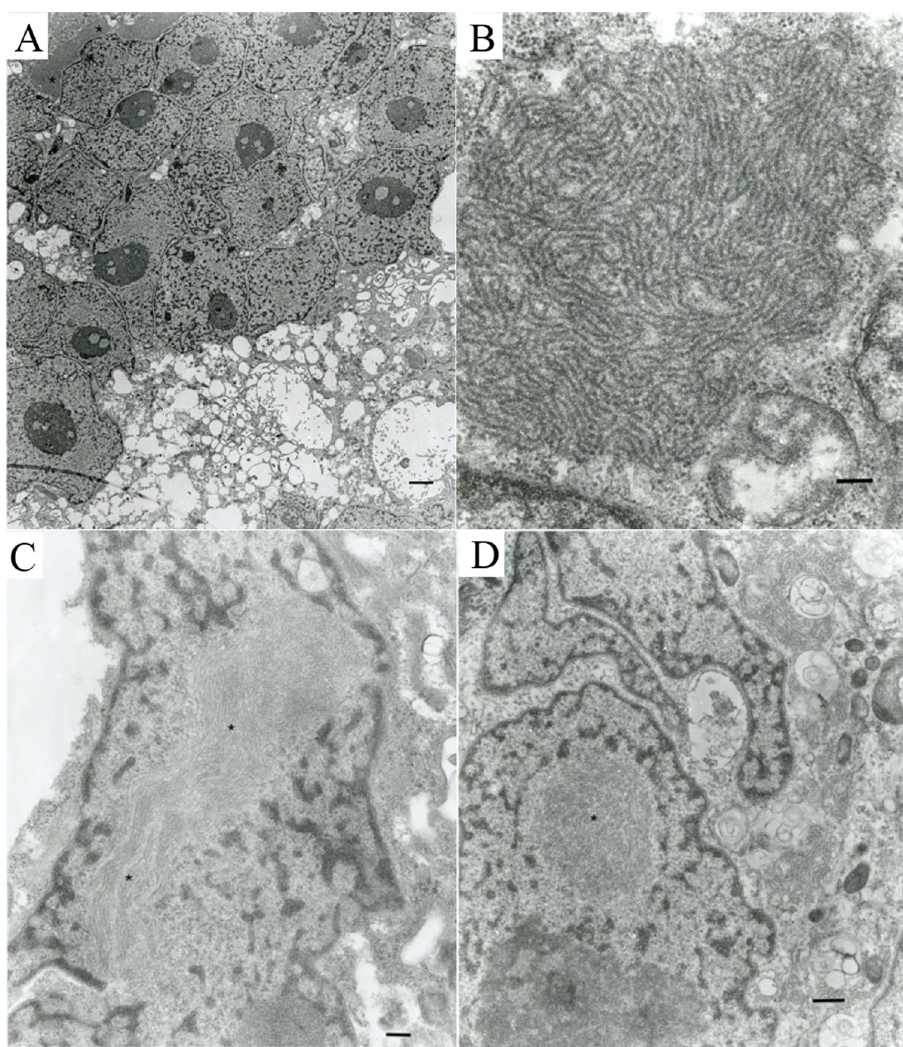
Figure 4. ( A ) A portion of a syncytium with multiple nuclei and a morbillivirus nucleocapsid cytosolic inclusion (upper left corner, asterisk). The surface of the monolayer (bottom) looks “foamy” due to multiple projections of plasmalemma forming multiple “vacuoles’. Bar = 2 µm; ( B ) A fragment of intracytosolic nucleocapsid inclusion with multiple (spiral) strands ~ 20 nm in diameter. A portion of the nucleus is in the left lower corner. Bar = 200 nm; ( C ) Large intranuclear inclusion of morbillivirus nucleocapsid (asterisk) in an attached cell in the monolayer 7 days post-infection (dpi). Bar = 200 nm; ( D ) Intranuclear inclusion of nucleocapsid in a syncytium (asterisk). Portions of two other nuclei at the top of an infected one. Attached cells 7 dpi. Bar = 500